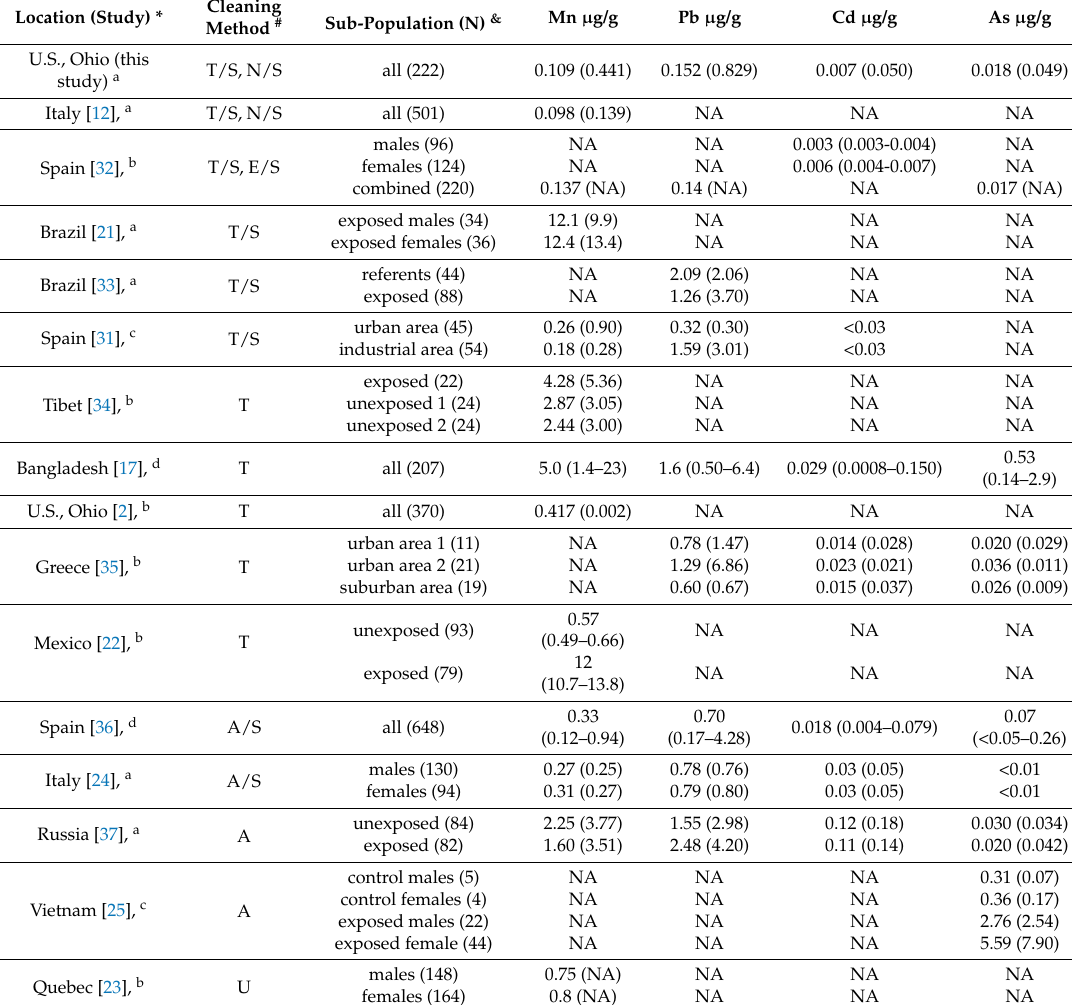
Table 4. Comparison of hair metal concentrations in children from the present study with levels reported in children (ages 4–14) in other studies that used a variety of different hair cleaning methods prior to